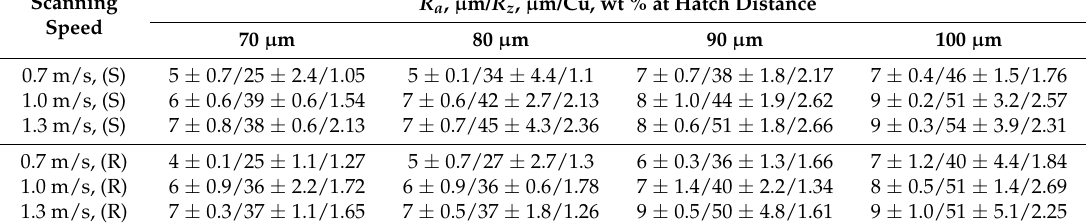
Table 1. Surface roughness R a , µ m and R z , µ m, and the average concentration of Cu, wt % in in situ alloyed Ti6Al4V (ELI)-1 at % Cu single layers manufactured with single scan (S) and rescan (R) manufacturing